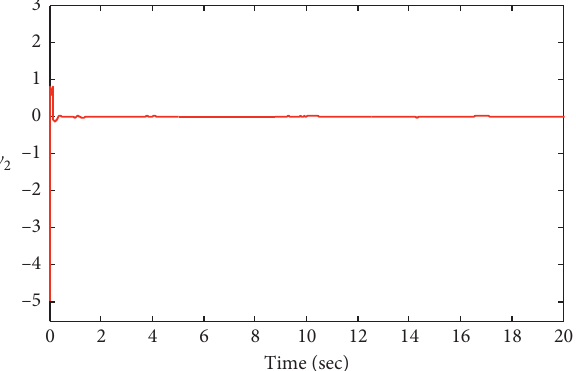
Figure 12: Profiles of the boundary layer error y